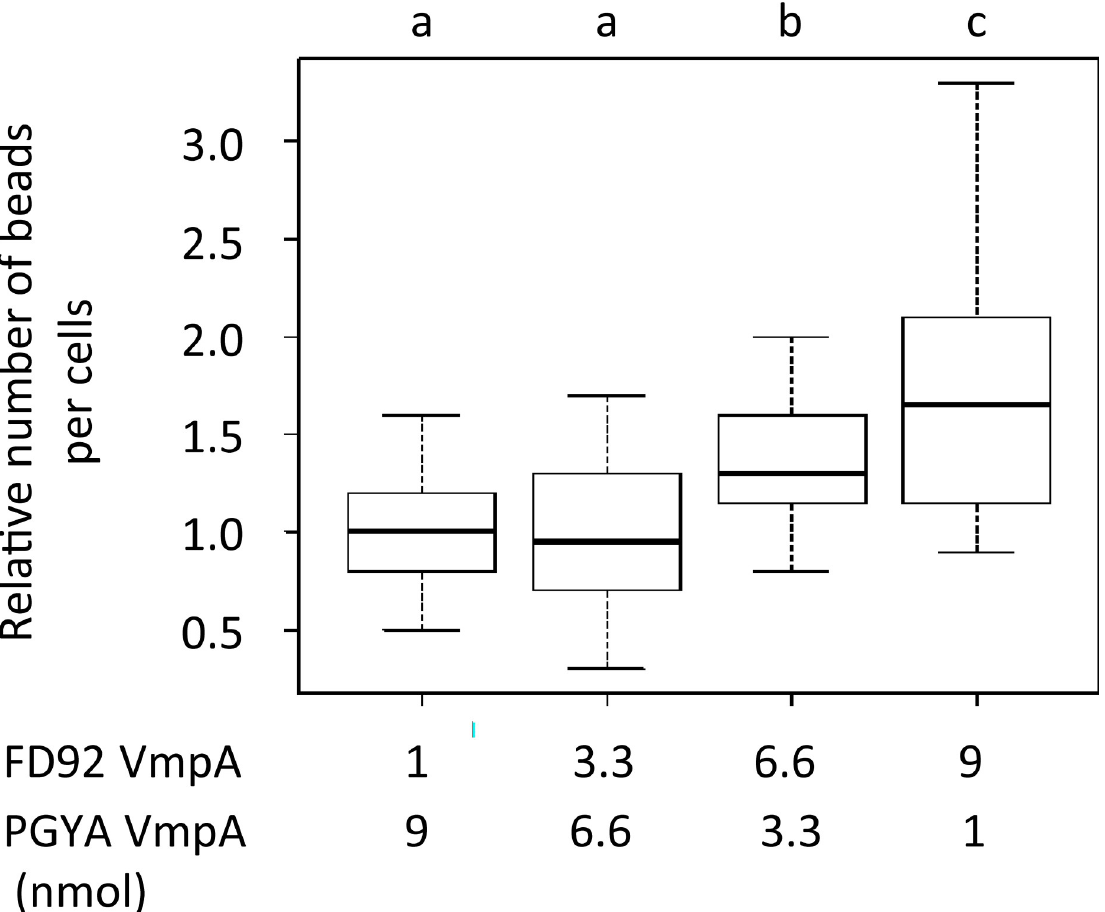
Fig 6. Adhesion of VmpA-His 6 -coated beads to the Euscelidius variegatus Euva-1 cells in culture. Fluorescent beads were coated with different amount of FD92 and PGYA VmpA-His 6 (quantities of proteins indicated under the graph) before being in contact with insect cells in culture. The 100% relative correspond to the condition of cell adhesion with fluorescent beads coated with 1 mmol FD92 VmpA plus 9 nmol PGYA VmpA. Boxplot with different letters are significantly different under the AnovaModel of R.The obtained p-values with Kruskal-Wallis test of R were P = 0.0000041 for the VmpA-FD92:vmpA-PGYA protein ratio 9:1 vs 1:9 and P = 0.00012 for the VmpA-FD92:vmpA-PGYA protein ratio 6.6:3.3 vs 1:9.